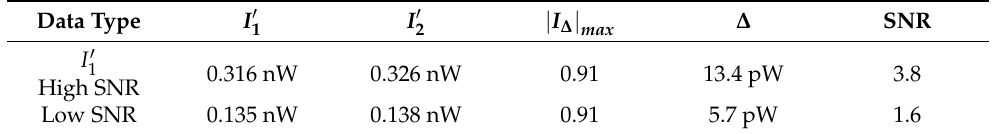
Table 1. SNR estimation for two sets of measured data.